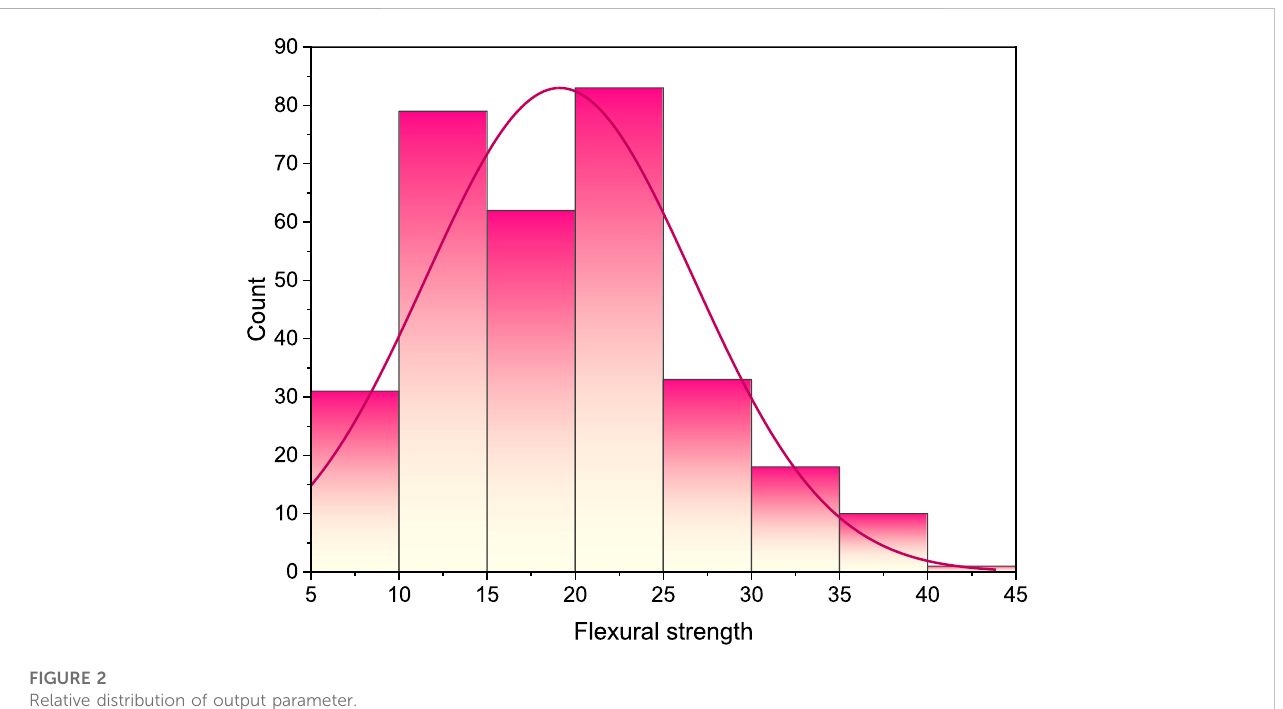
FIGURE 2 Relative distribution of output